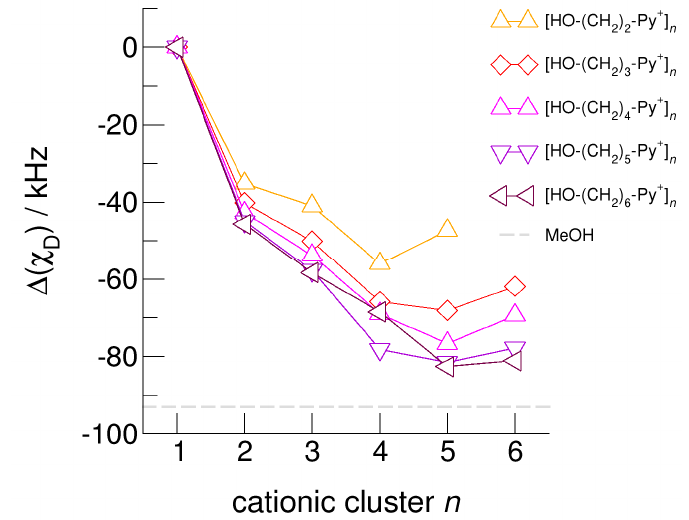
Figure 10. Calculated average deuteron quadrupole coupling constants, χ D , of the hydroxyl deuterons for the cationic clusters [HO-(CH 2 ) 2 -Py + ] n , [HO-(CH 2 ) 3 -Py + ] n , [HO-(CH 2 ) 4 -Py + ] n , [HO-(CH 2 ) 5 -Py + ] n , and [HO-(CH 2 ) 6 -Py + ] n related to the corresponding monomer values. For comparison, we show the ( χ D ) difference of deuteron quadrupole coupling constants of methanol MeOH in the liquid and the gas phase (grey dashed line) [65–67].